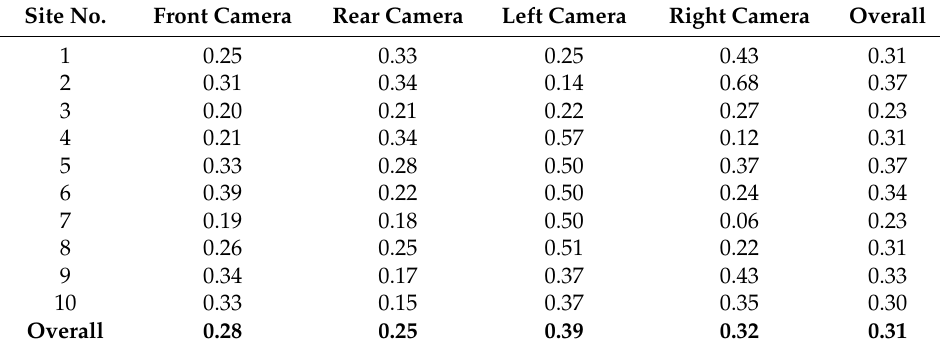
Table 3. Average Camera Angle Error with Parameter Co-Refinement and Parameter Selection (Degree).